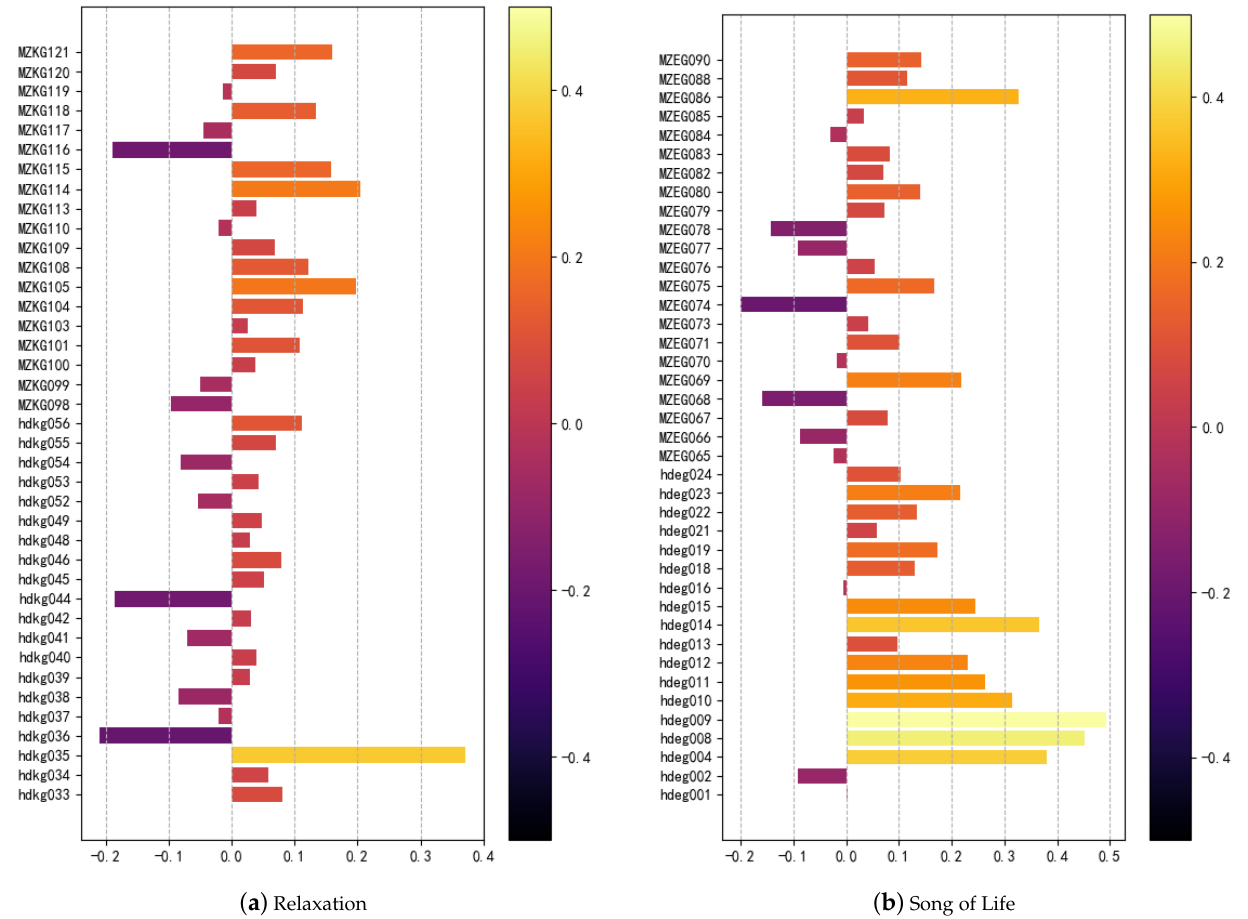
Figure 1. The differences in patients’ overall state score between pre- and post-intervention.